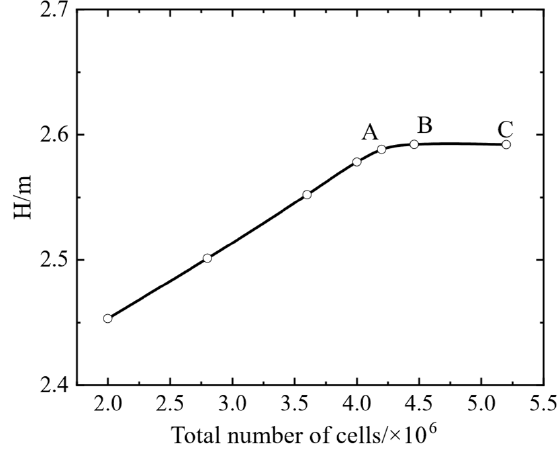
Table 2. The number of grids in each computational domain of the axial-flow pump.